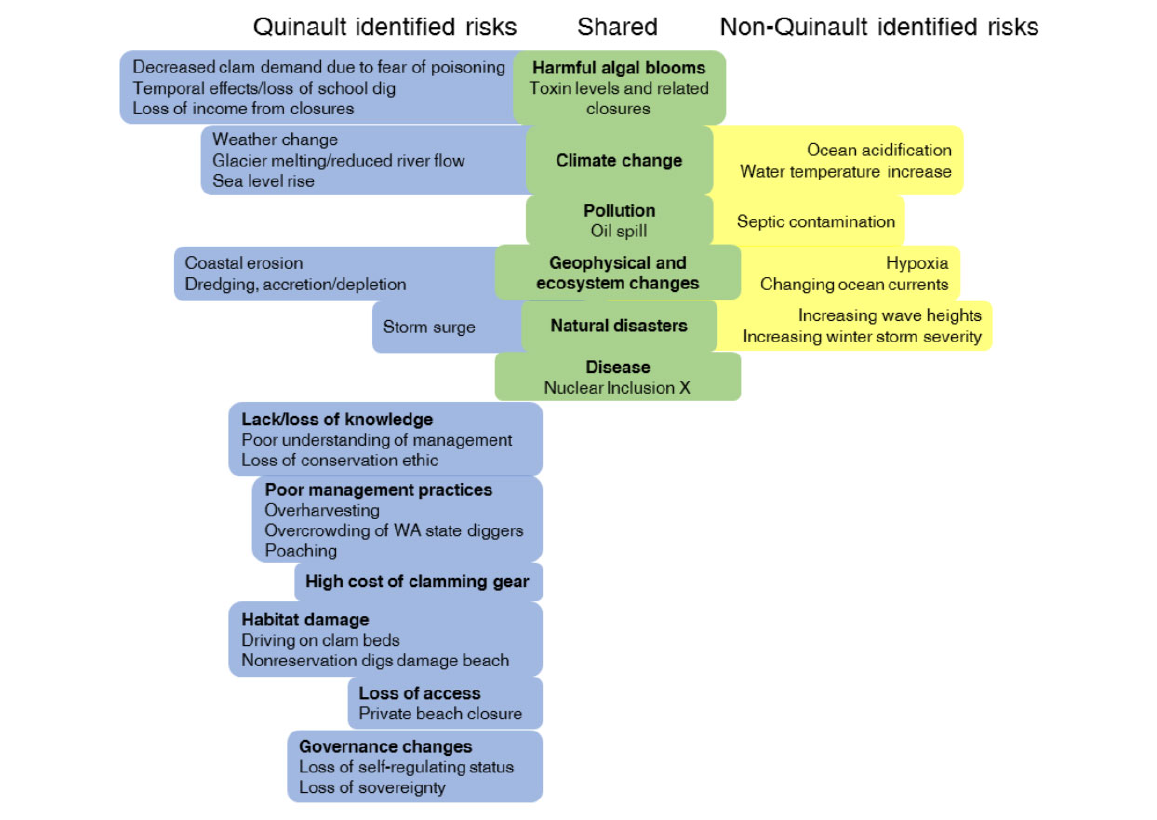
Fig. 4 . Comparison of risks to the razor clam ( Siliqua patula ) resource identified by members of the Quinault Indian Nation (left, blue) and non-Quinault scientists and natural resource managers (right, yellow), along with risks identified by both parties (middle, green). The order of risks is ranked first by the number of QIN members who mentioned each of the shared risks, and then the number of QIN members who mentioned each additional ecological and social